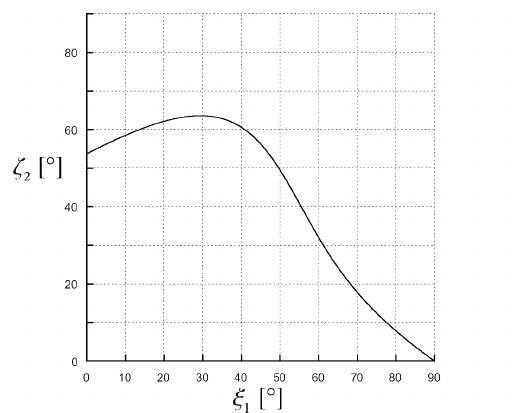
Figure 9. Transmitted angle of the attenuation vector, ζ 2 in degrees, as a function of the incident angle of the phase vector, ξ 1 in degrees. Medium 1 is a vacuum, medium 2 has ε (cid:48) The magnitude of the incident phase vector is the critical one in Equation (3) when ε (cid:48)